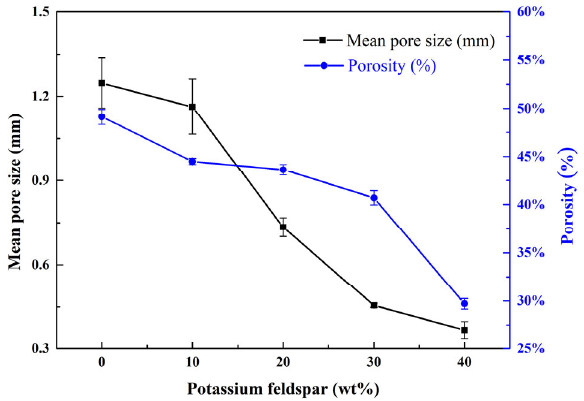
Figure 14. Cross-sectional images of samples with different potassium feldspar at 1200 ◦ C for 20 min.